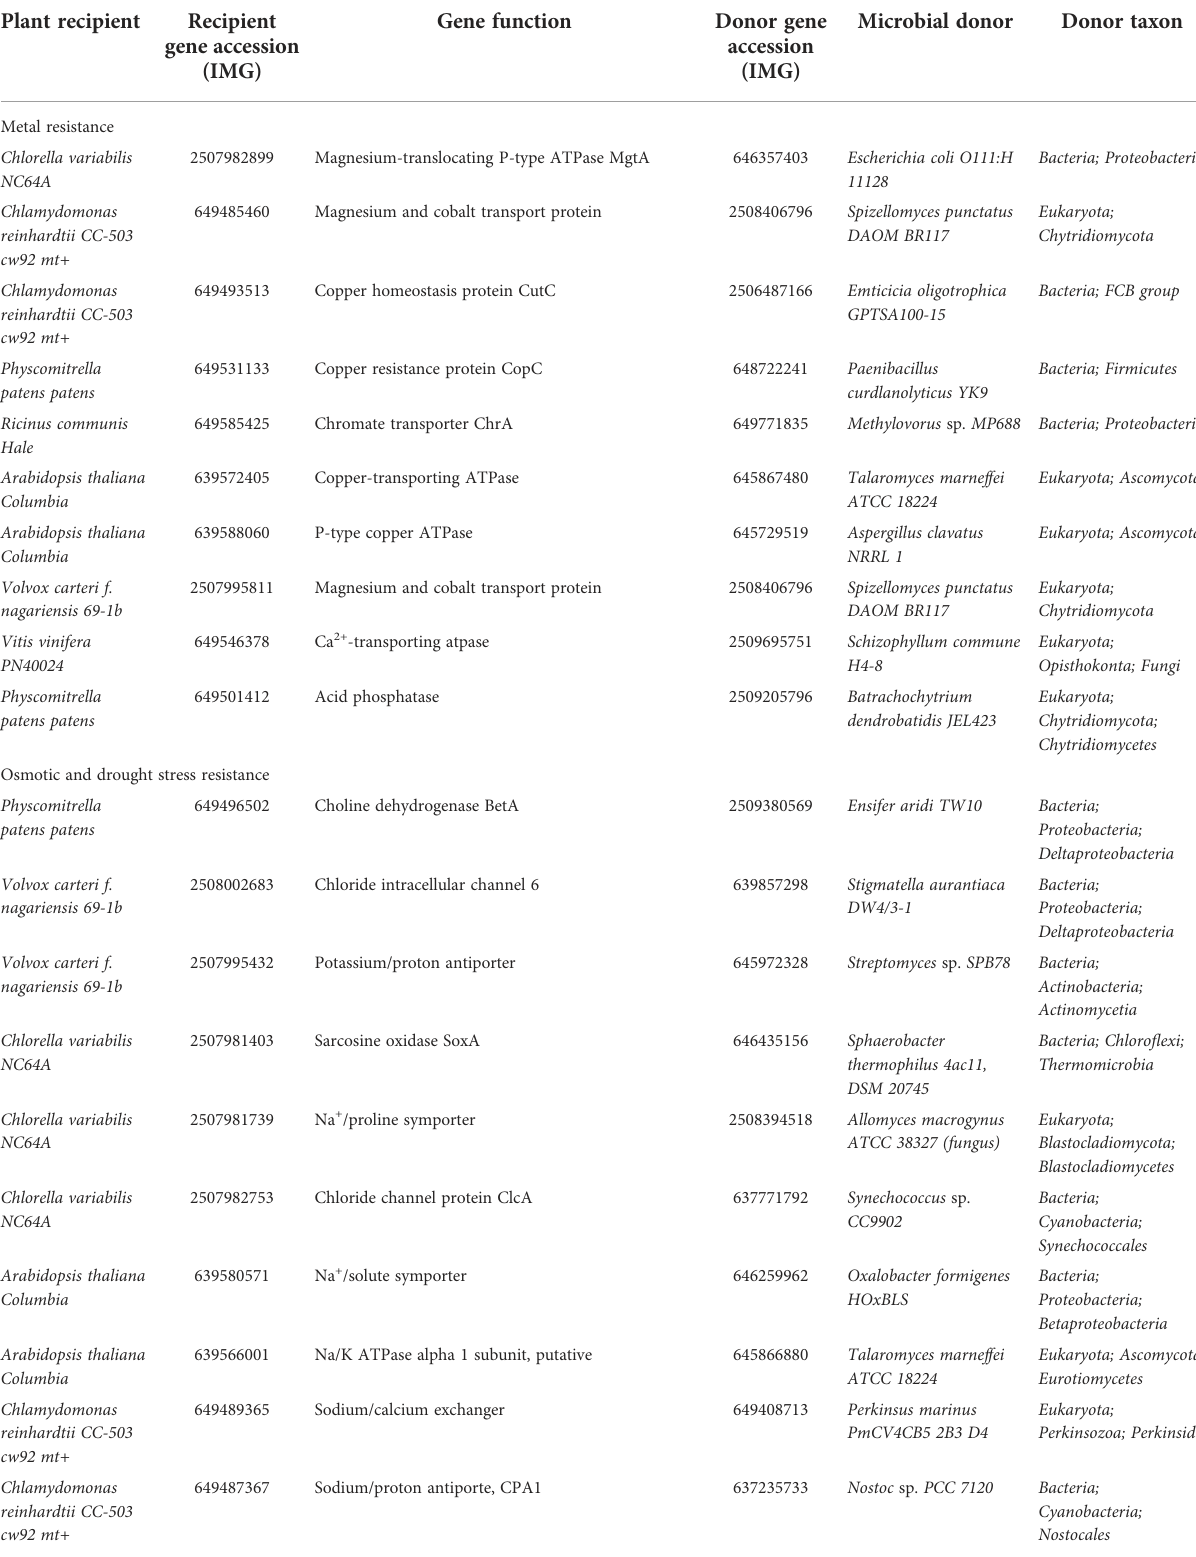
TABLE 2 Microbe-originated HGT genes identi fi ed in tested plant genomes that associated with miscellaneous abiotic stress resistance. Plant